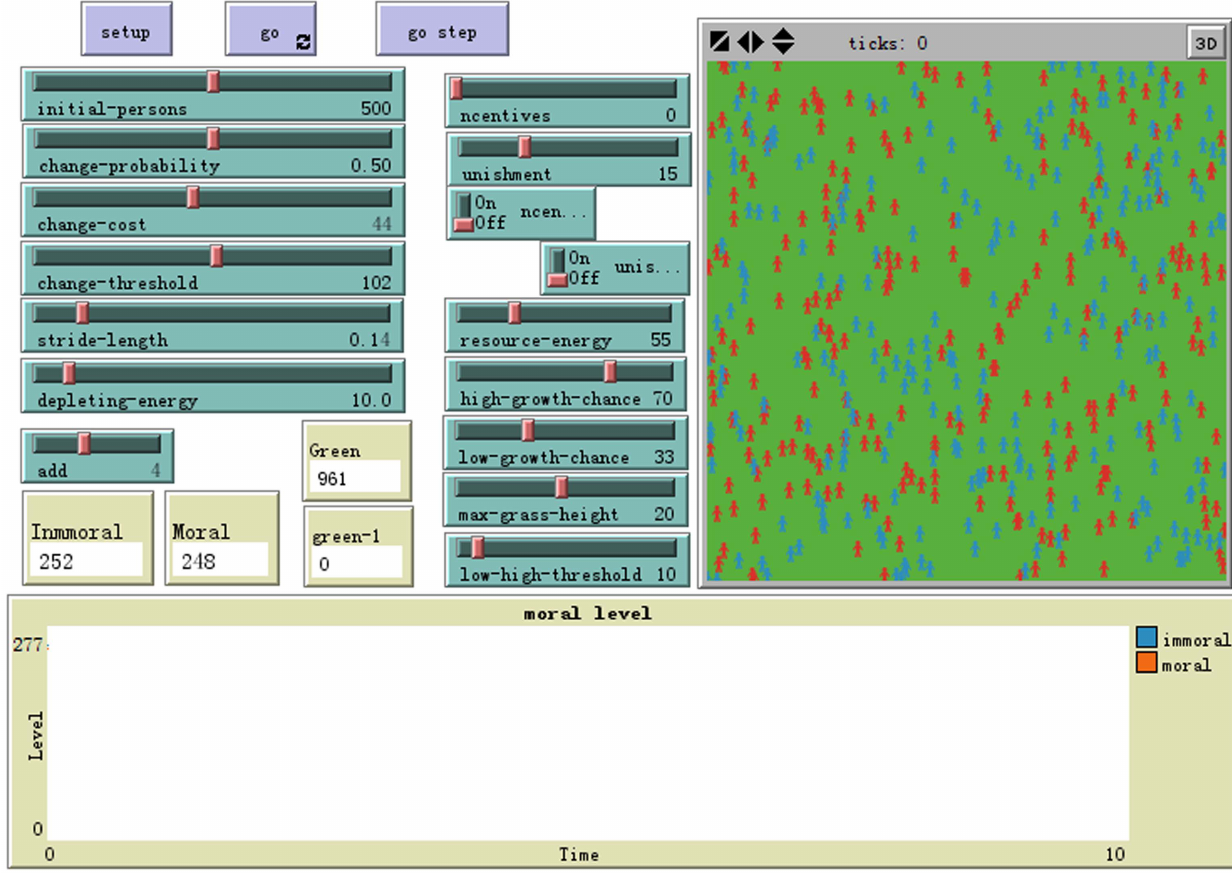
Figure 2. NetLogo interface of the simulation mode. NetLogo is a multi-agent programmable modeling environment. Here is the simulation interface that was developed by authors. This model includes the command area, parameters area, chart area and image area. Command area is responsible for the control of initialization parameters and operating procedures. Parameters area allows to dynamically adjust the parameters. The chart area display the simulation results. Image area can be dynamically displays the status of agents.